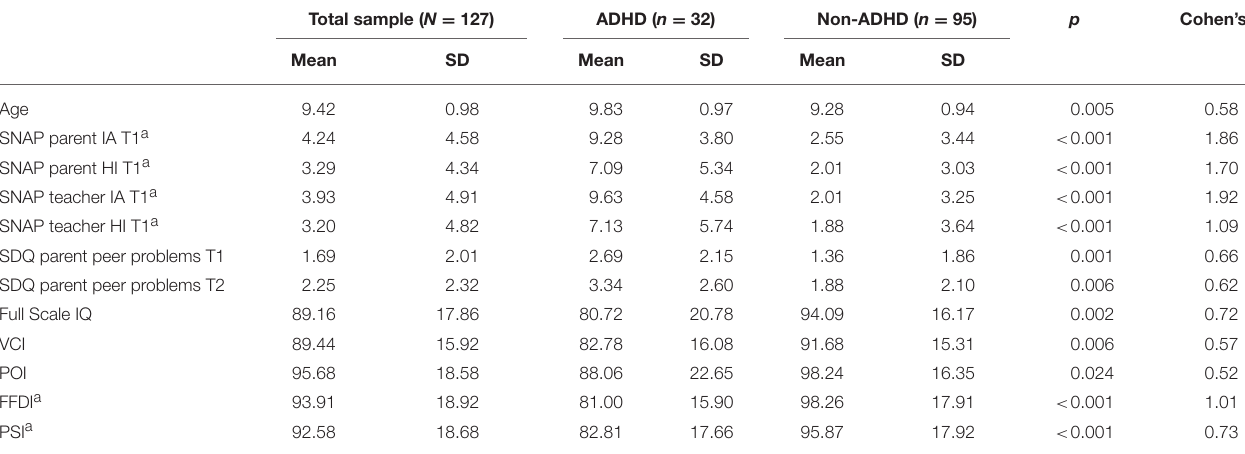
TABLE 1 | Age, SNAP subscales, and intellectual function.